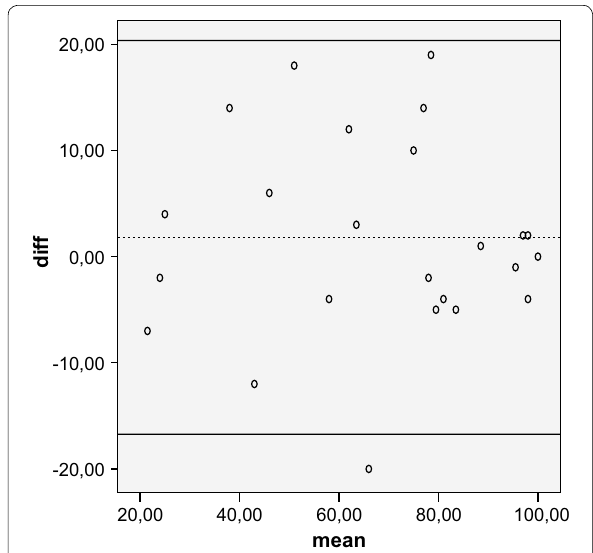
Fig. 1 Bland–Altman plot showing test–retest results for 33 patients completing the Italian version of the Kujala index. The dashed line shows the mean difference; solid lines show the 95 % confidence